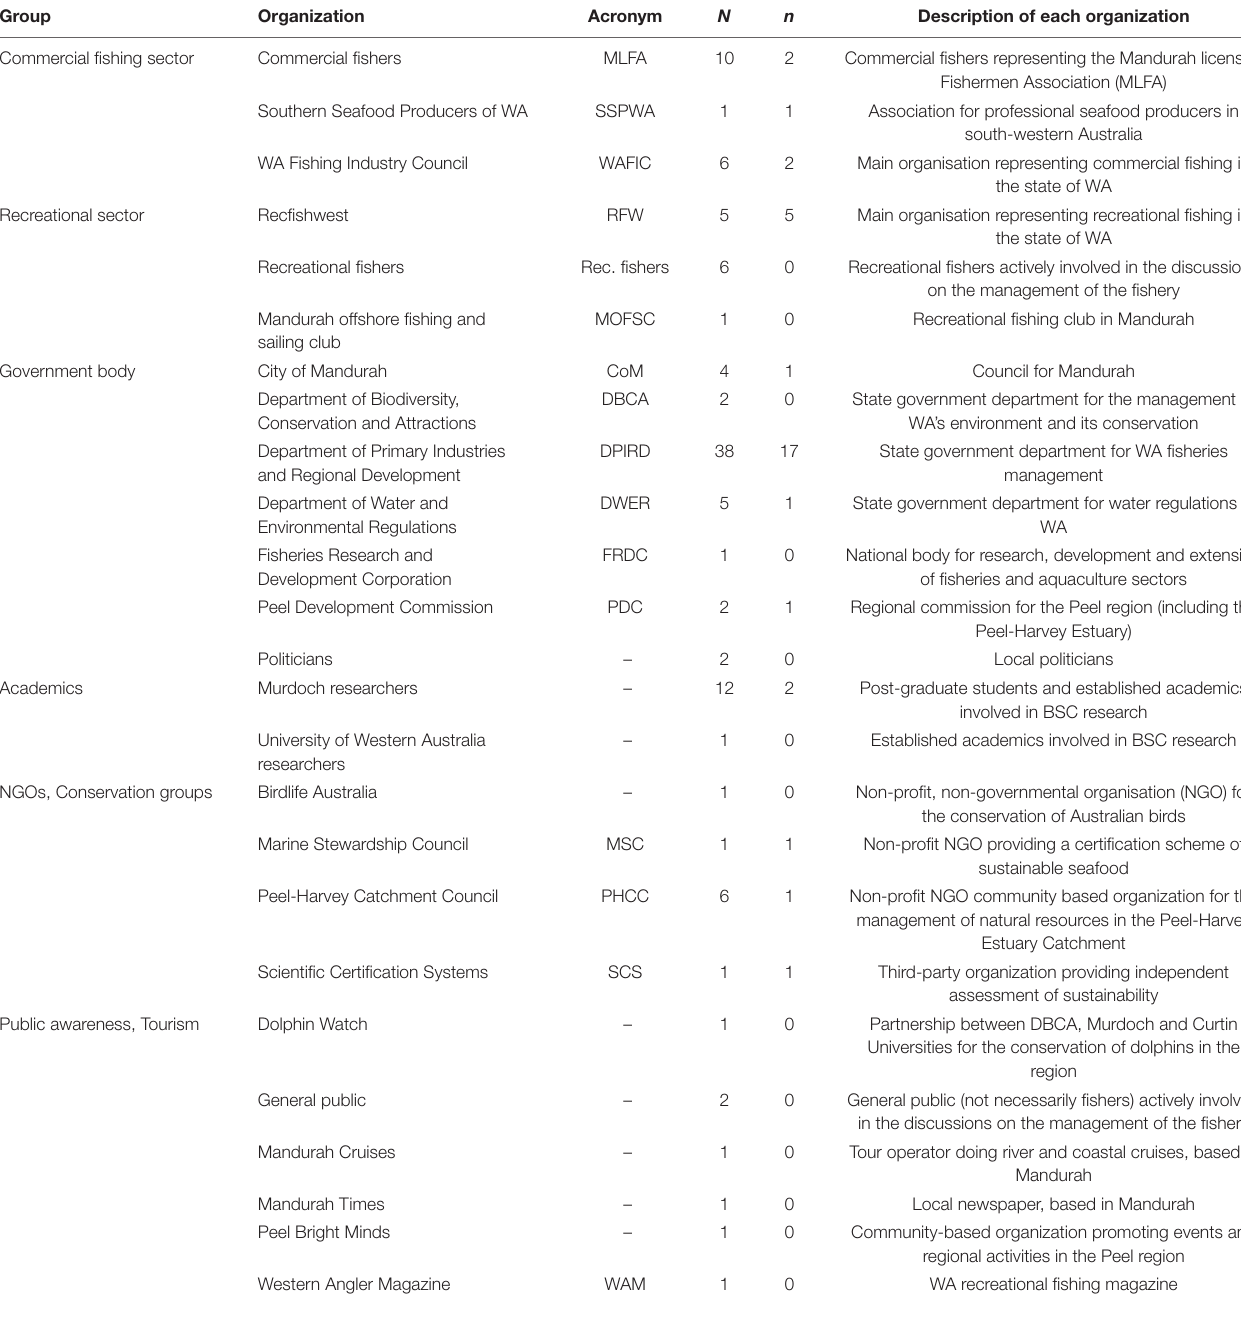
TABLE 1 | Organisations forming the PHBSC fishery network and acronyms used for each organisation, groups they are affiliated with, description of each organisation and total individuals mentioned ( N = 112) and individuals interviewed ( n = 35) for each organisation.